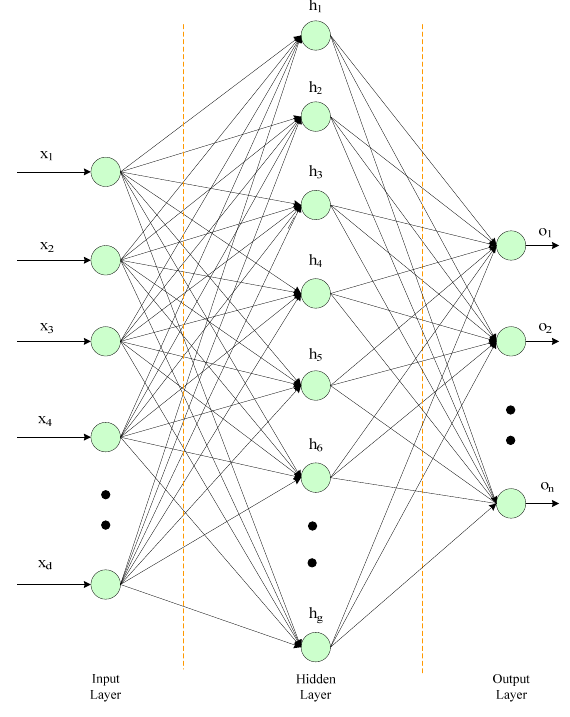
Figure 1. Architecture of the back propagation neural network and radial basis function (RBF) neural